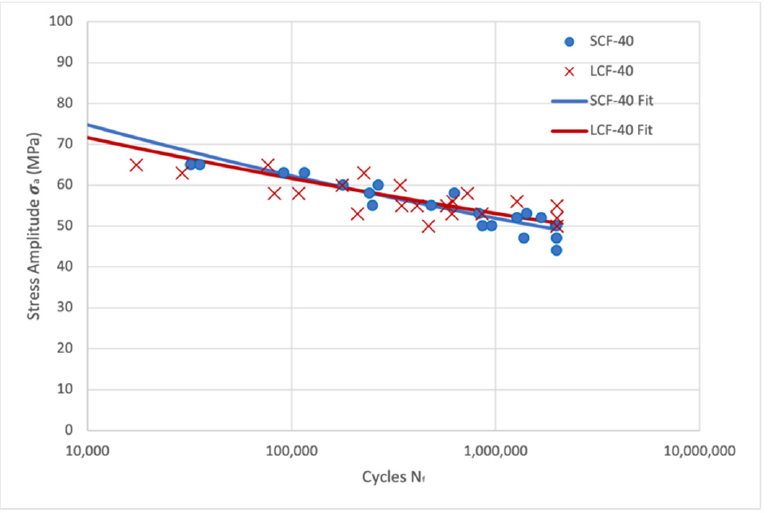
Figure 4. Fatigue tests results at room temperature with R = − 1 for the SCF and LCF materials. The fit parameters to the Basquin Equation (1) for both LCF and SCF material along with the number of experiments to create Figure 4 are given in Table 3. Table 3. Fatigue test Basquin equation fit parameters for room temperature. Parameter